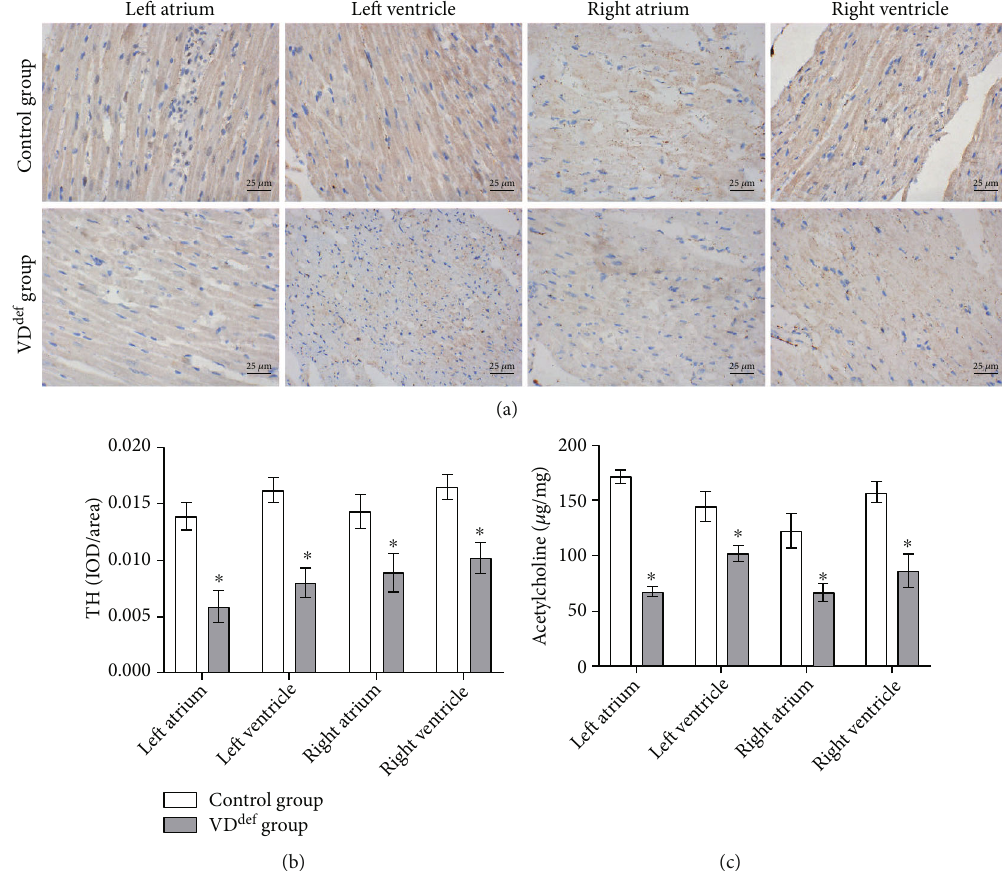
Figure 3: VD de fi ciency changes the expression of neurotransmitter in the autonomic nervous system of rats. (a) IHC was used to detect the expression of TH in rat cardiomyocytes ( × 400, scalebar = 25 μ m ). (b) IOD value of TH. (c) ELISA was used to detect the level of Ach. ∗ P < 0 : 05 vs. the control